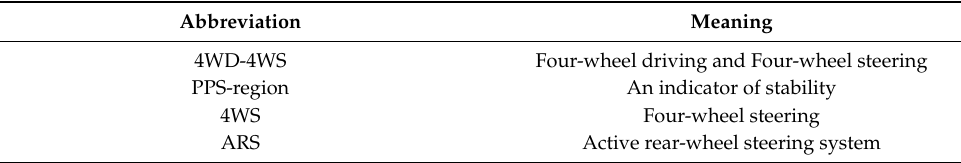
Table 2. Abbreviation